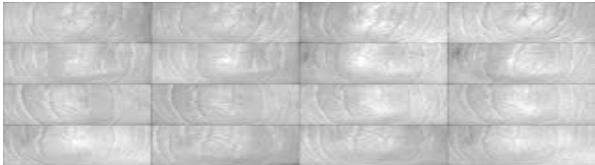
Figure 12. A cropped sample of the finger knuckle print (FKP) database [63].